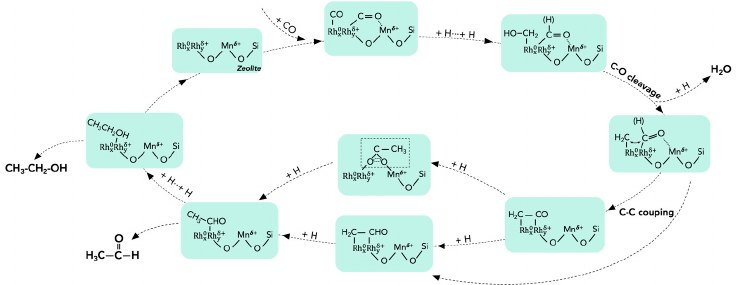
Figure 10. A proposed reaction pathway for syngas-to-ethanol transformation over the RnMn@S-1 catalyst. Adapted with permission from Chem 2020, 6, 646-657 [60]. Copyright 2020 Elsevier.